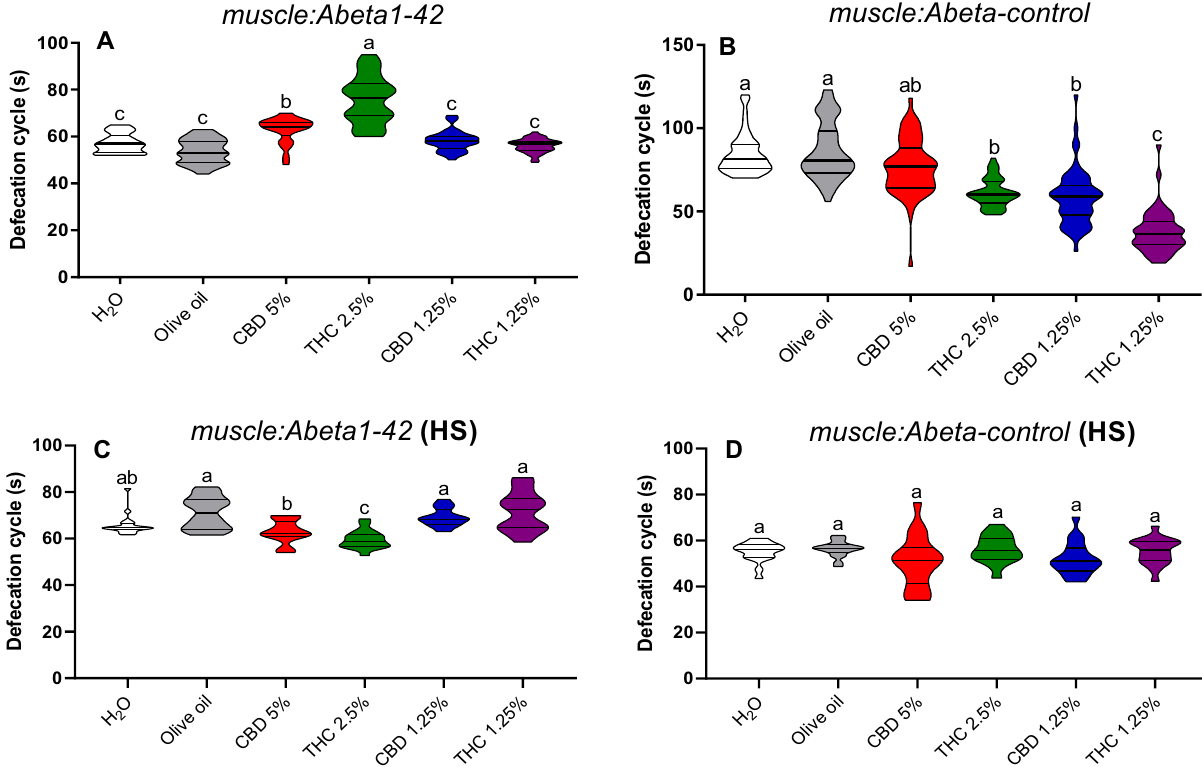
Figure 6. Defecation cycle rate in non-stressed ( A , B ) and heat-stressed (HS) ( C , D ) C. elegans muscle:Abeta1-42 and muscle:Abeta-control transgenic strains. Data are expressed by the mean ± standard error (SEM). Means followed by the same letter are not significantly different according to Dunn’s test ( p >